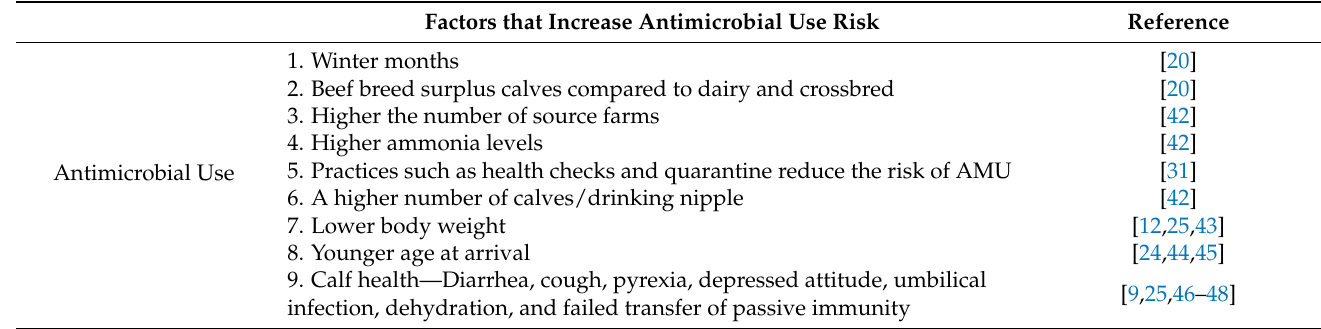
Table 1. Risk factors contributing to increased antimicrobial use in surplus calves. Factors that Increase Antimicrobial Use Risk